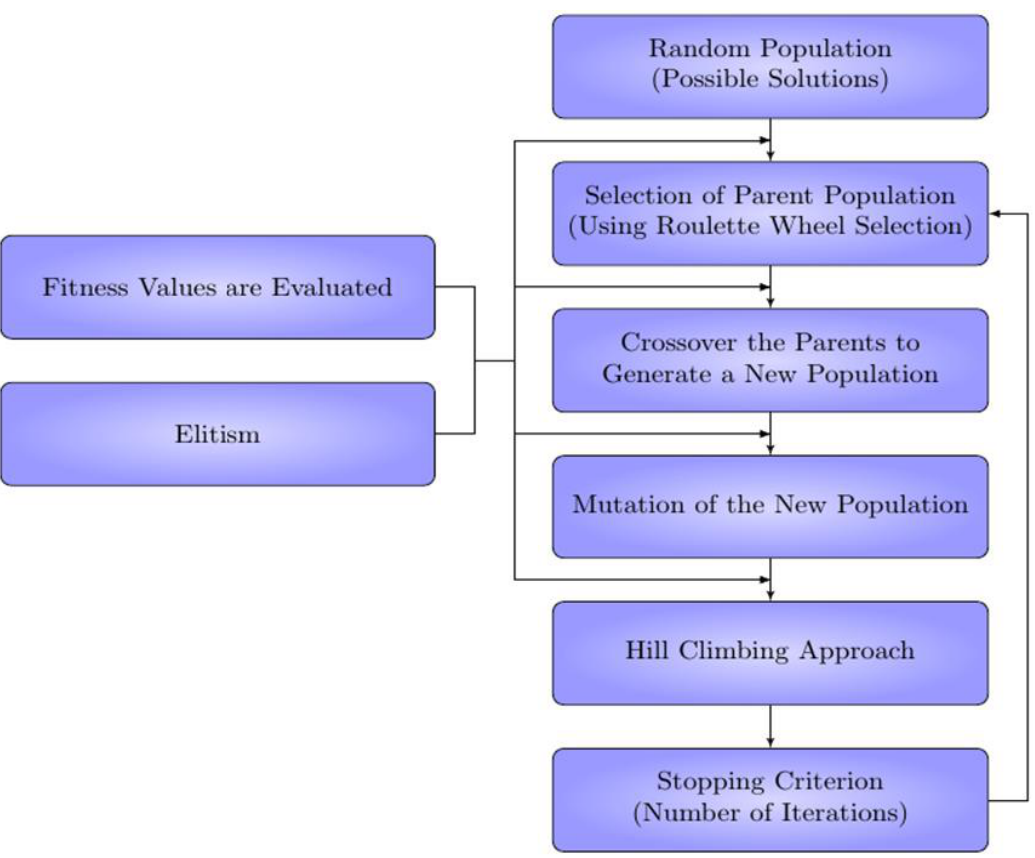
Figure 2. Flow diagram of the hybrid genetic algorithm (HGA) developed at Idaho National Laboratory.